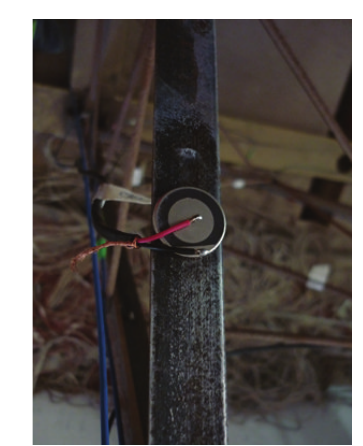
Figure 12: The PZT